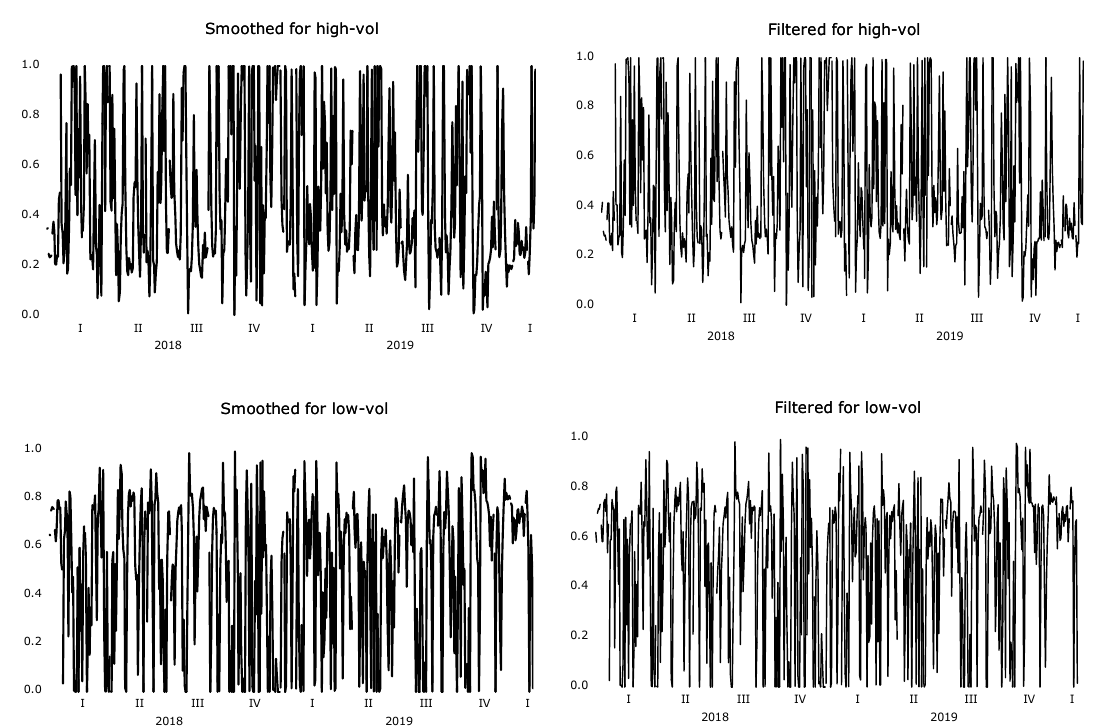
Figure 4. Computed smoothed probabilities and filtered conditional volatilities for FINX.